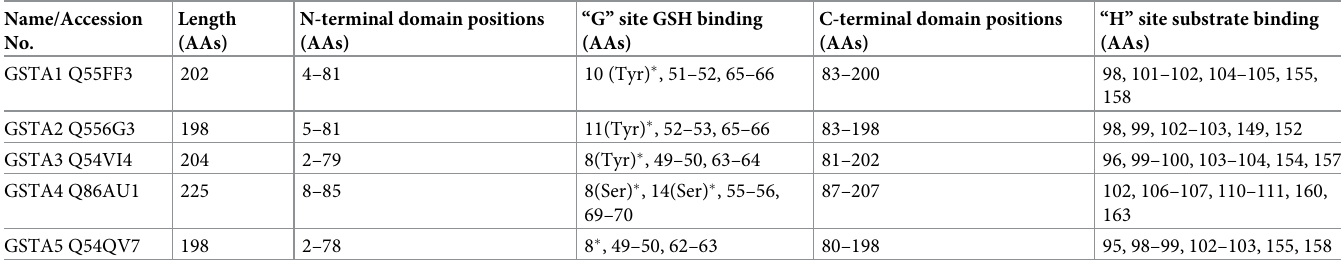
Table 1. Amino acid sequence analysis of D . discoideum GST Isozymes.